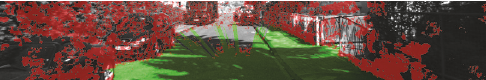
Figure 8, this point of view is sensitive to noisy